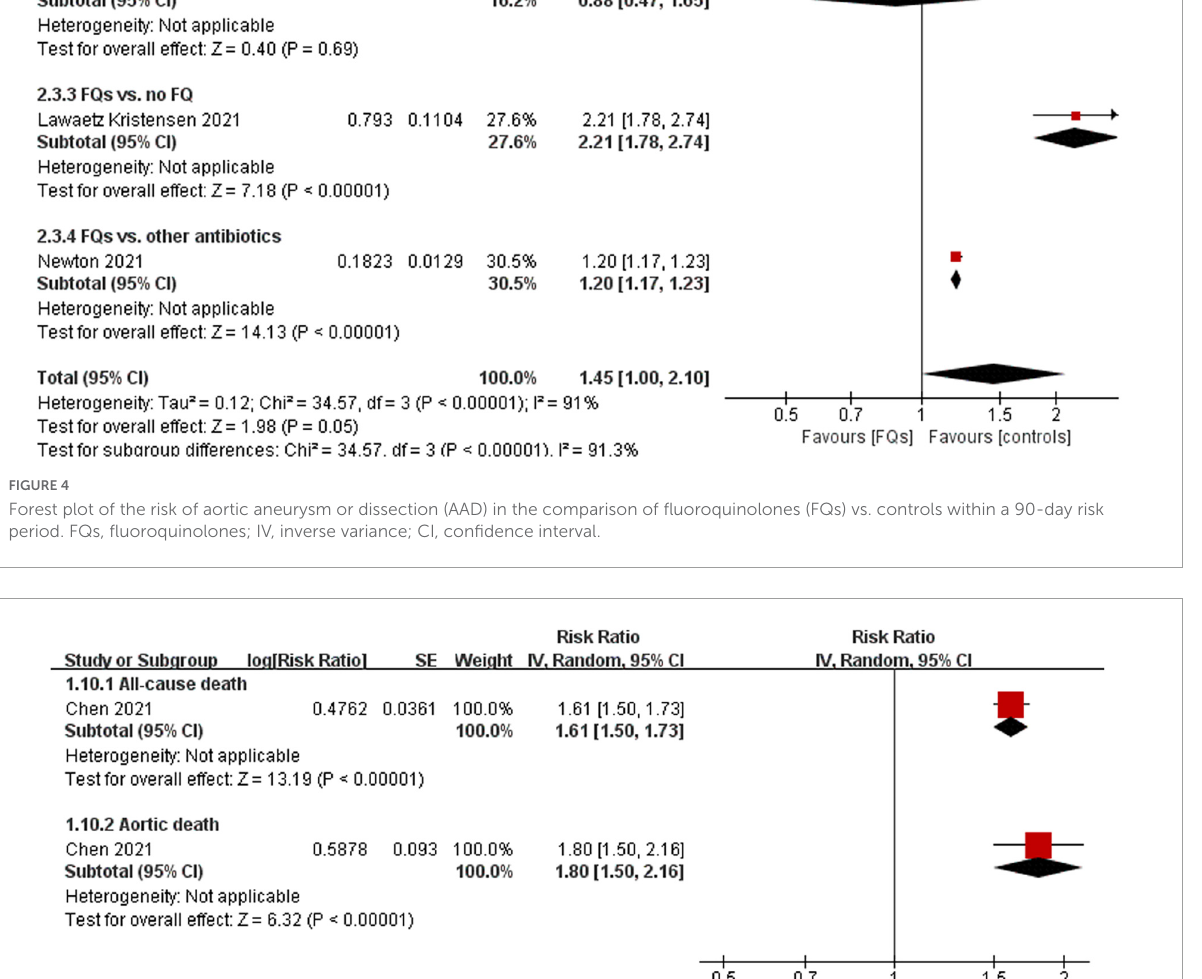
FIGURE5 Forest plot of mortality risk of aortic aneurysm or dissection (AAD) patients in the comparison of fluoroquinolones (FQs) vs. control within a 60-day risk period. FQs, fluoroquinolones; IV, inverse variance; CI, confidence interval.